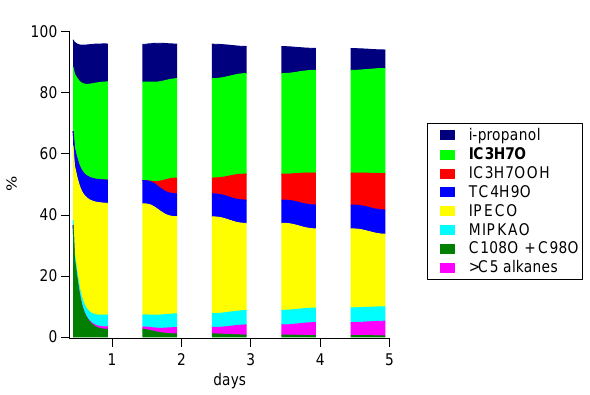
Fig. 6. Relative contribution of reaction pathways to the formation of acetone. See Fig. 7 for explanation of the MCM codenames.